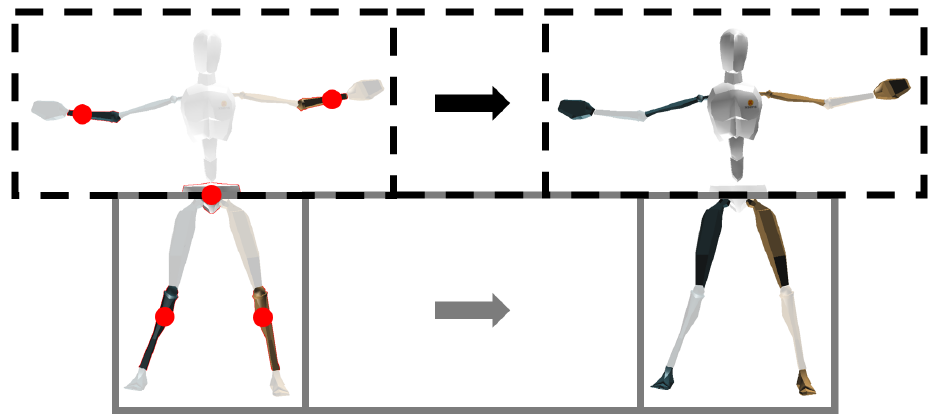
Figure 1. The left pose shows an example of input segment orientations (highlighted and sensor locations are marked with red dots) for both the upper- and lower-body estimations, whereas the right pose shows the corresponding output segment orientations (highlighted) for both the upper- and lower-body. Both estimations (displayed as black dotted and grey boxes) are combined to obtain the full-body